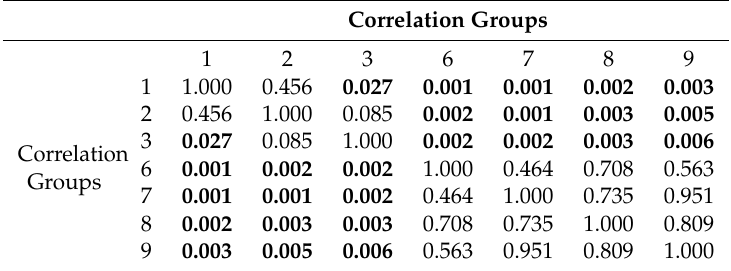
Table 4. p -values between the median results of variable V 6 “keratinocyte diameter” obtained from the spectra of the corresponding correlation groups.